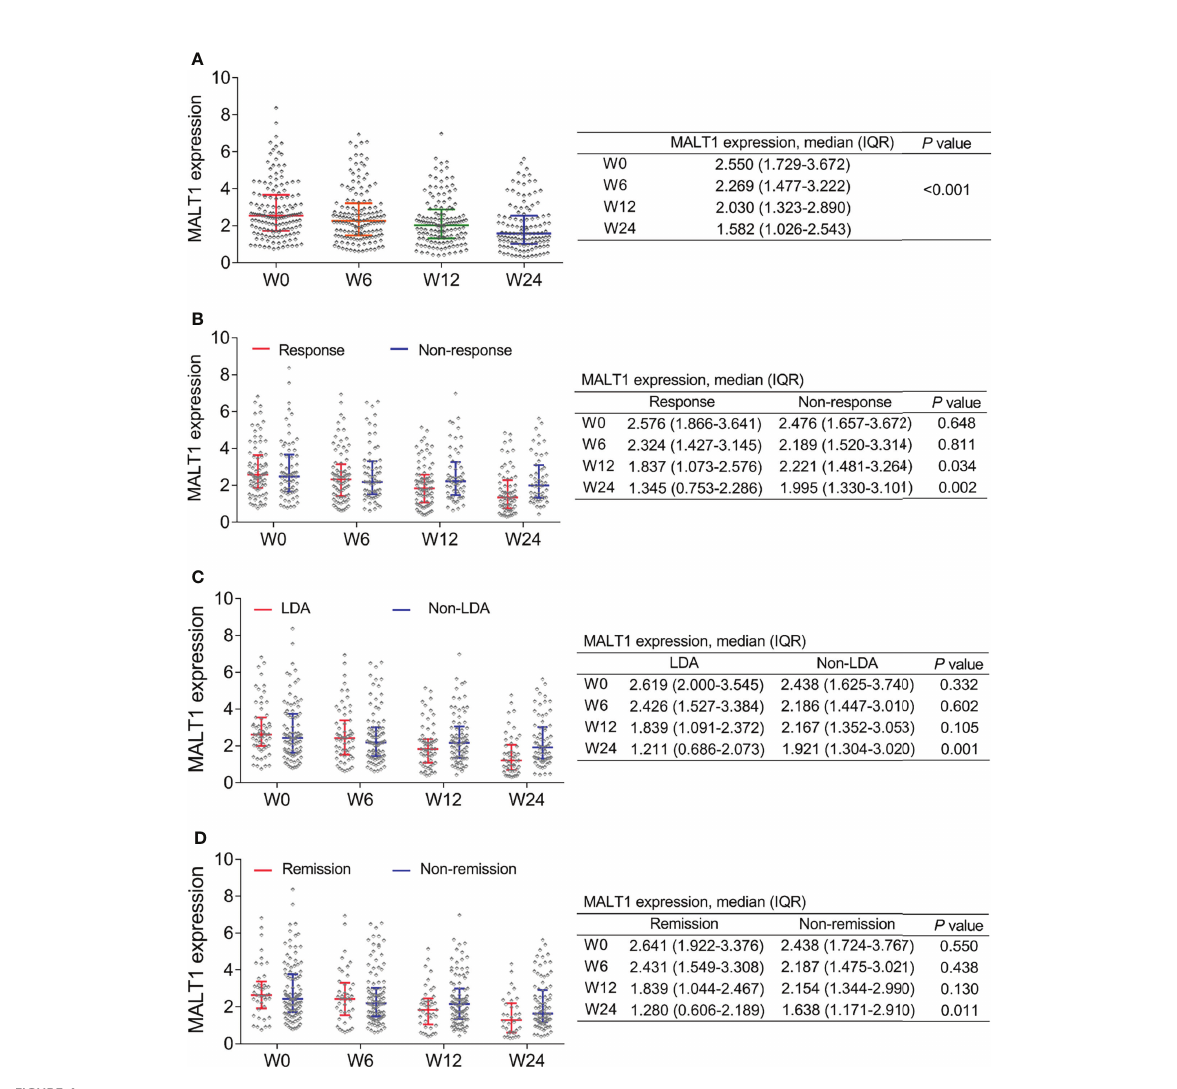
FIGURE 4 MALT1 ’ s change during treatment and outcome. Longitudinal change of MALT1 expression during treatment in RA patients (A) . Comparison of MALT1 expression at W0, W6, W12, and W24 between response patients and non-response patients (B) , between LDA patients and non-LDA patients (C) , between remission patients and non-remission patients (D)